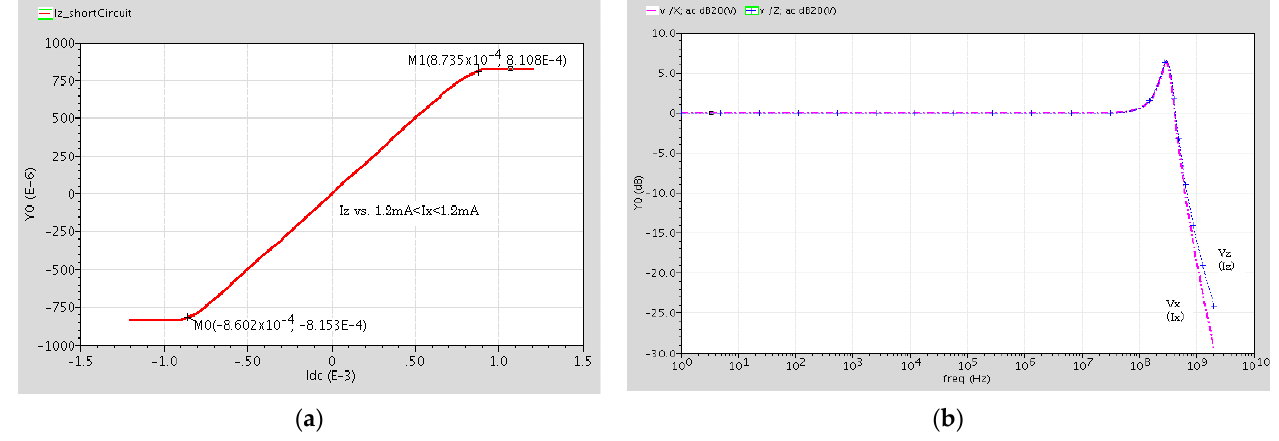
Figure 4. ( a ) Output current of terminal Z versus terminal X input current, when terminal Z is shorted. ( b ) Current frequency response (I z /I x ) of the DVCC. ( b ) Current frequency response (I z /I x ) of the DVCC.